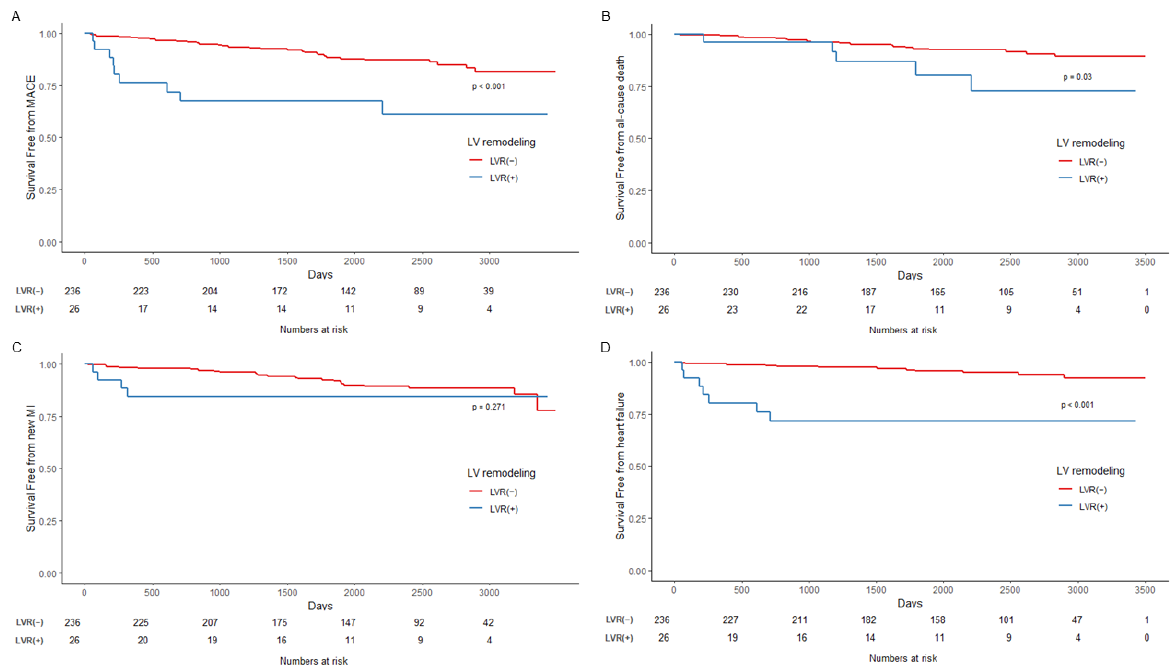
Figure 3. Kaplan – Meier curves for outcomes. ( A ) Composite outcome of all-cause death, myocardial infarction, and readmission due to heart failure, thus MACE; ( B ) All-cause death; ( C ) Myocardial infarction; ( D ) Readmission due to heart failure. LVR = left ventricular remodeling; MACE = major adverse cardiovascular outcome; MI = myocardial infarction.